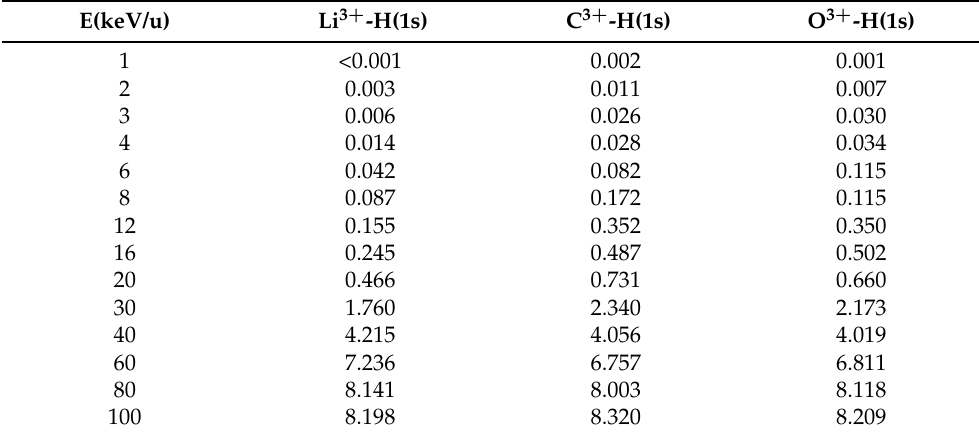
Table A3. Total ionization cross sections (10 − 16 cm 2 ) for Li 3 + , C 3 + , and O 3 + collisions with ground- state hydrogen from 1 to 100